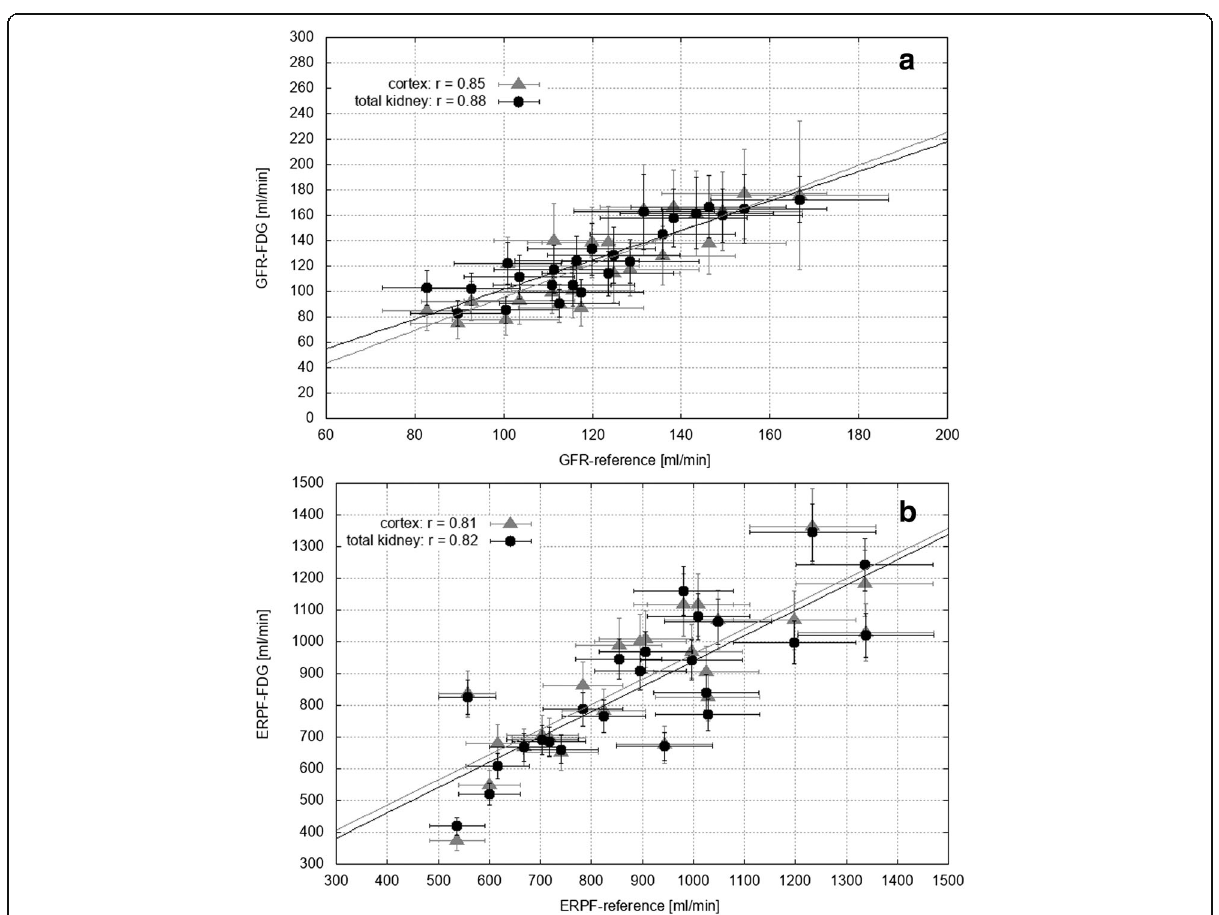
Fig. 5 Reference values versus values obtained from total kidney (black) and cortex (gray) FDG TACs (time activity curves), for a GFR (glomerular filtration rate) and b ERPF (effective renal plasma flow). Lines of best fit are also shown. Error bars represent the calculated errors of each data point